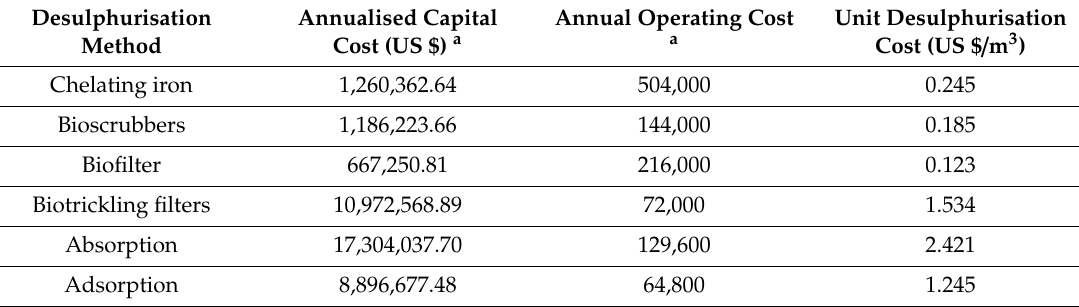
Table 6. Estimated annualised capital cost, annual operating cost and unit desulphurisation cost for desulphurisation technologies of the use of chelating irons, bioscrubbers, biofilters, biotrickling filters, adsorption, and absorption